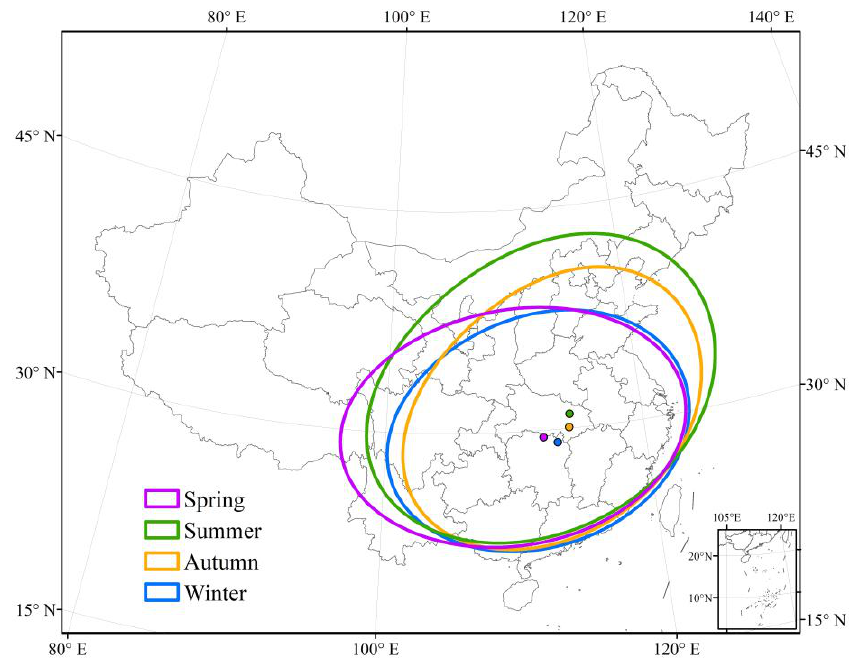
Figure 6. Standard deviational ellipse of seasonal variation of CH 4 emission from terrestrial ecosystem in China.